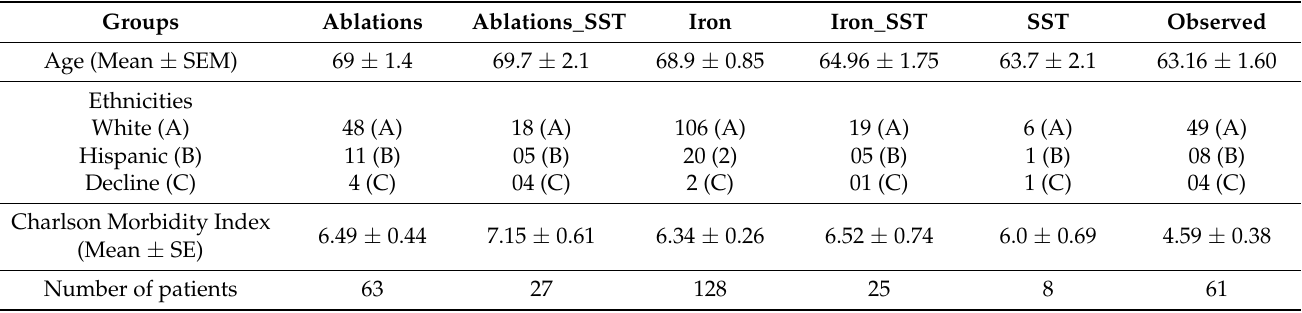
Table 1. Demographic and morbidity index of the study